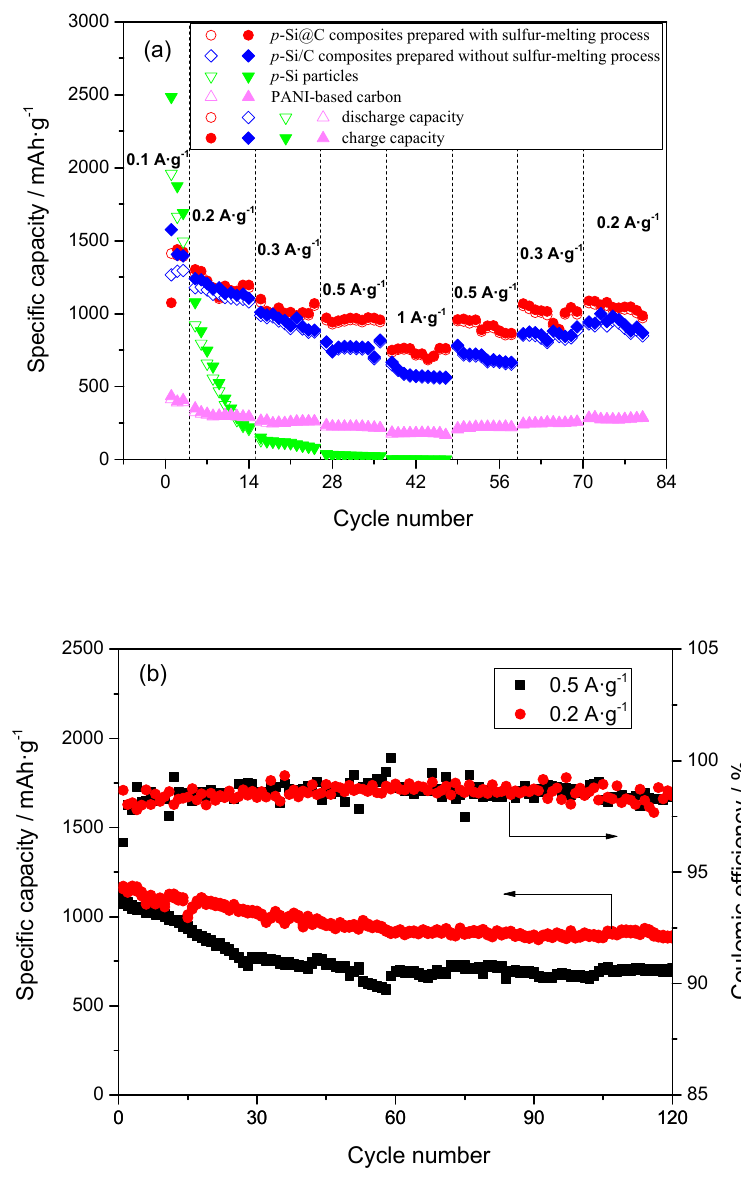
Figure 6. ( a ) High-rate capabilities for p -Si particles, PANI-based carbon and p -Si@C composites prepared with and without sulfur-melting process and ( b ) cycling stability of p -Si@C composites with carbon content of 45 wt.% at 0.2 and 0.5 A·g − 1.